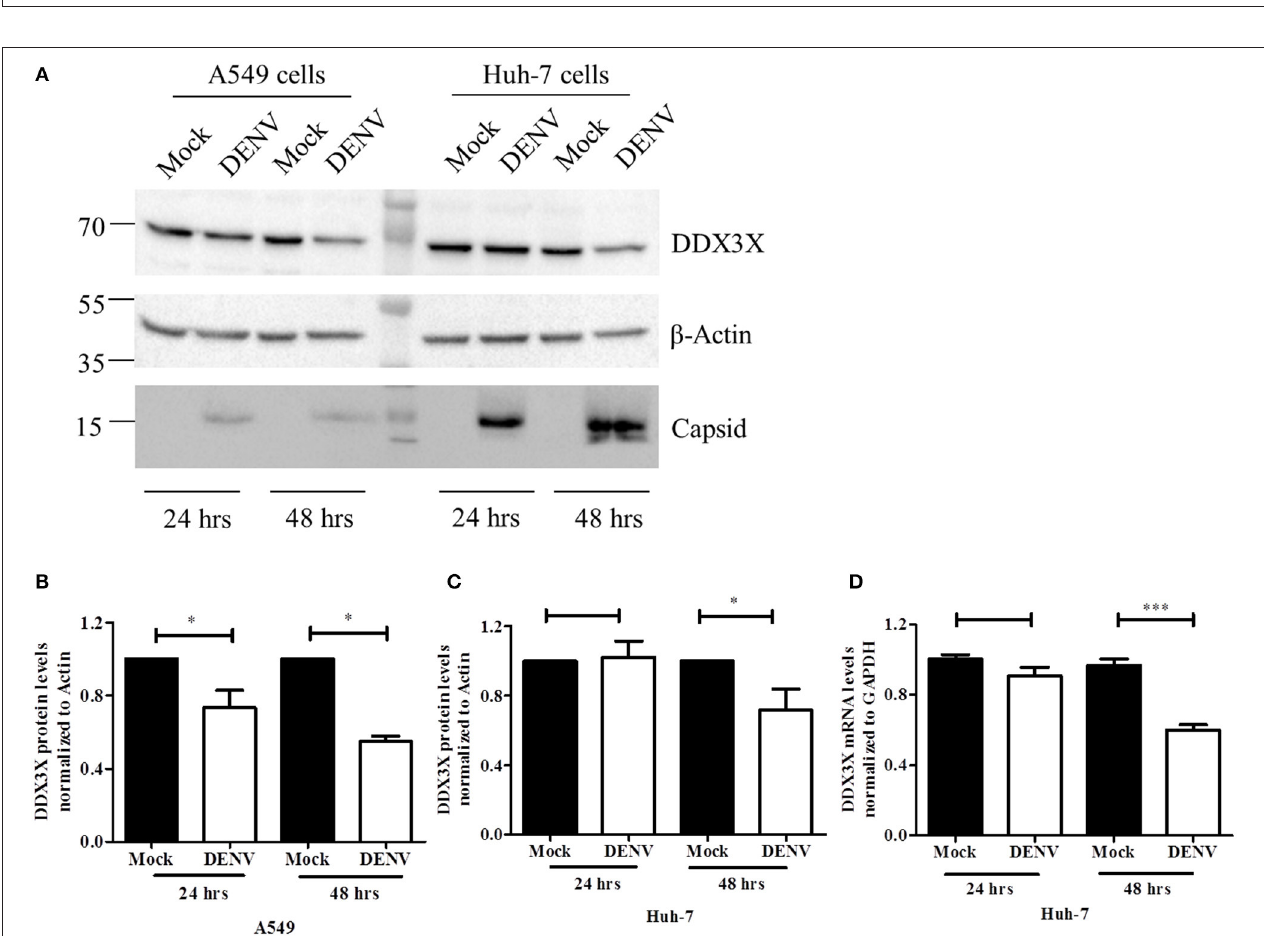
FIGURE 2 | HA-DDX3X deletion constructs. (C) Total lysates were prepared from HEK293T cells transfected with HA-DDX3X-FL and HA-DDX3X deletion constructs at 24h p.t. Purified His-capsid was added to the lysate for in-solution interaction and protein complexes were pulled down by Ni-NTA beads. Lysates incubated with Ni-NTA beads only were used as negative control. The beads were washed, boiled in Laemmli buffer and loaded on SDS PAGE and probed for HA-tag, capsid and Actin. In the first lane of blot (i) purified His-capsid was loaded as a positive control for capsid antibody. Total lysate of HEK293T cells transfected with